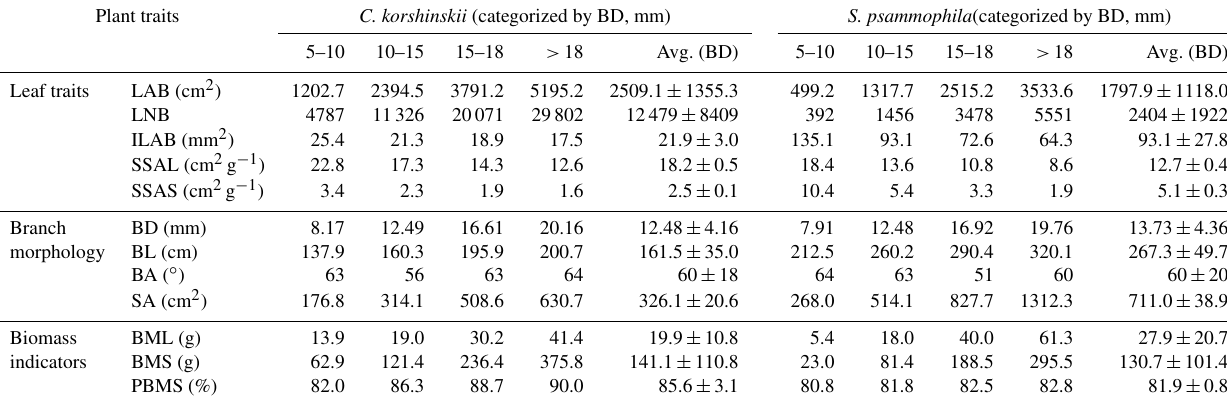
Table 1. Comparison of leaf traits, branch morphology and biomass indicators of C. korshinskii and S. psammophila . Plant traits Leaf